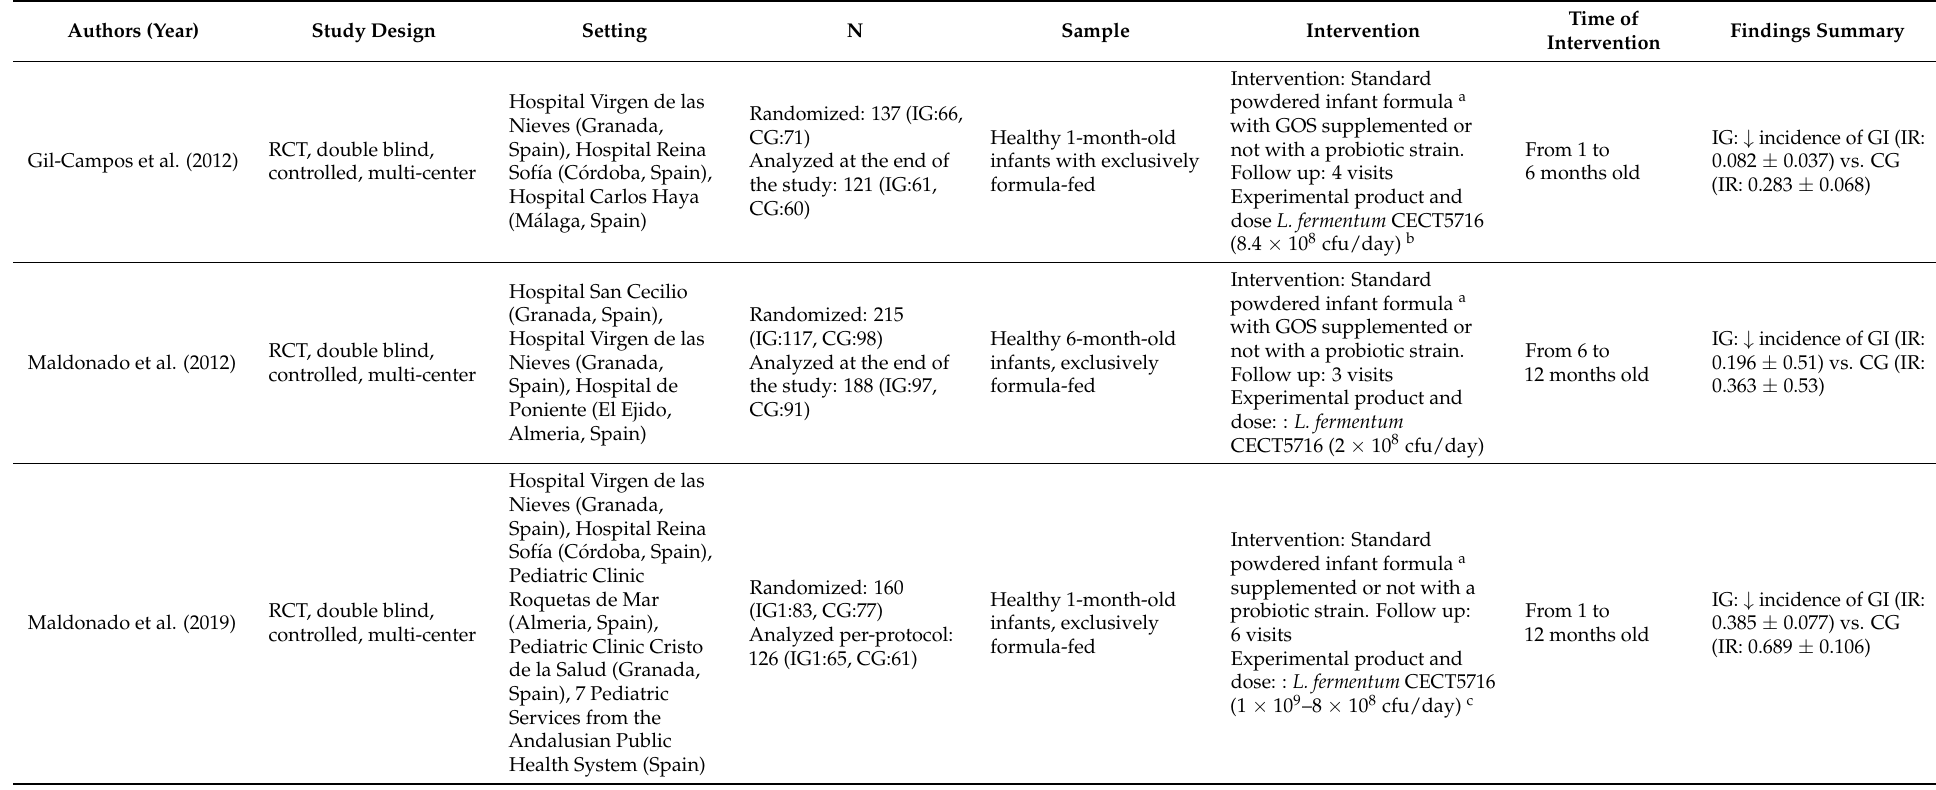
Table 1. Summary of characteristics of included